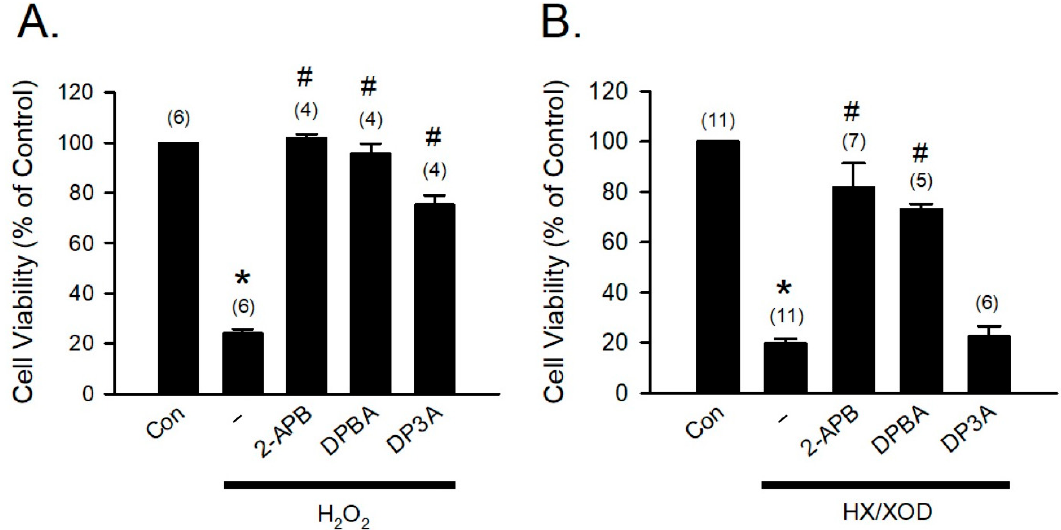
Figure 5. Protective effects of 2-APB, DPBA, and DP3A on the H 2 O 2 - or HX/XOD-induced cell death in H9c2 cells. ( A ) 2-APB, DPBA, and DP3A at a concentration of 100 µ M significantly inhibited the H 2 O 2 (100 µ M)-induced cell death. * p < 0.05 different from control; # p < 0.05 different from the H 2 O 2 group. ( B ) 2-APB (100 µ M) and DPBA (100 µ M), but not DP3A (100 µ M), significantly inhibited the cell death induced by HX/XOD (HX: 0.2 mM, XOD: 2 mU/mL). * p < 0.05 different from control; # p < 0.05 different from the HX/XOD group. Values shown in parenthesis represent the number in each group. Data are expressed as mean ± SEM. Abbreviations: Con, Control; HX/XOD, hypoxanthine/xanthine oxidase.